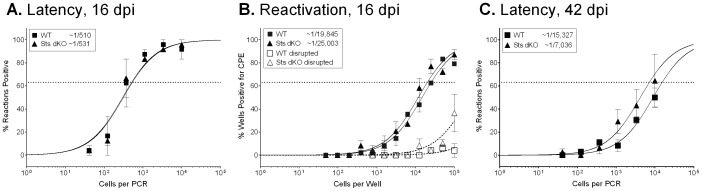
Viral latency and reactivation from latency are unchanged in Sts dKO animals.Sts dKO and C57BL/6 WT mice were infected with 1000 PFU of MHV68 by the intranasal route and single cell suspensions of the spleens were prepared at 16 dpi. (A) Frequency of splenocytes harboring viral genomes determined by limiting dilution nested PCR assay. (B) Frequency of splenocytes reactivting virus determined by a limiting dilution ex vivo reactivation assay. (C) Frequency of splenocytes harboring viral genomes at 45-57. For all limiting-dilution assays, curve fit lines were derived from nonlinear regression analysis, and symbols represent the mean percentage of wells positive for virus (viral DNA or CPE) ± the standard error of the mean. The dotted line represents 63.2%, from which the frequency of viral genome-positive cells or the frequency of cells reactivating virus was calculated based on the Poisson distribution. Graphs represent 3 independent experiments of 3–4 mice.